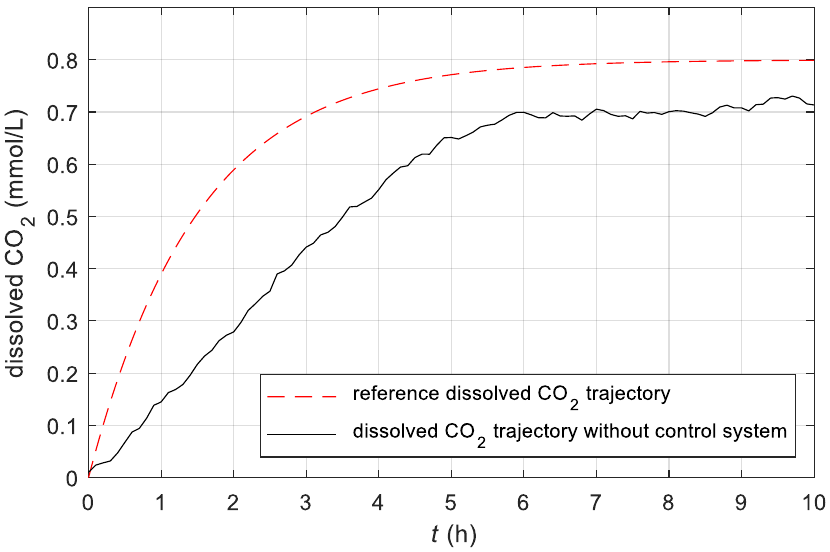
Figure 5. The trajectory of the dissolved CO 2 of the original fermentation process in batch bioreactor without a control system (solid line) and the reference trajectory of the dissolved CO 2 of the batch bioreactor (dashed line); data of the original fermentation process with fully activated kefir grains are shown in Table 2; the reference trajectory is described with Equation (20).